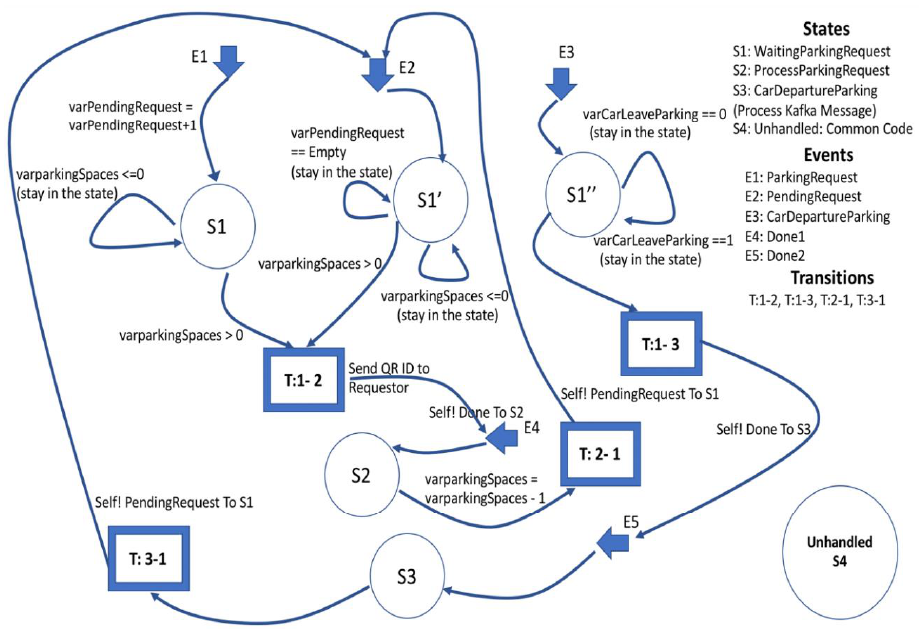
Figure 13. Reservation allocation service model based on an Akka FSM actor.